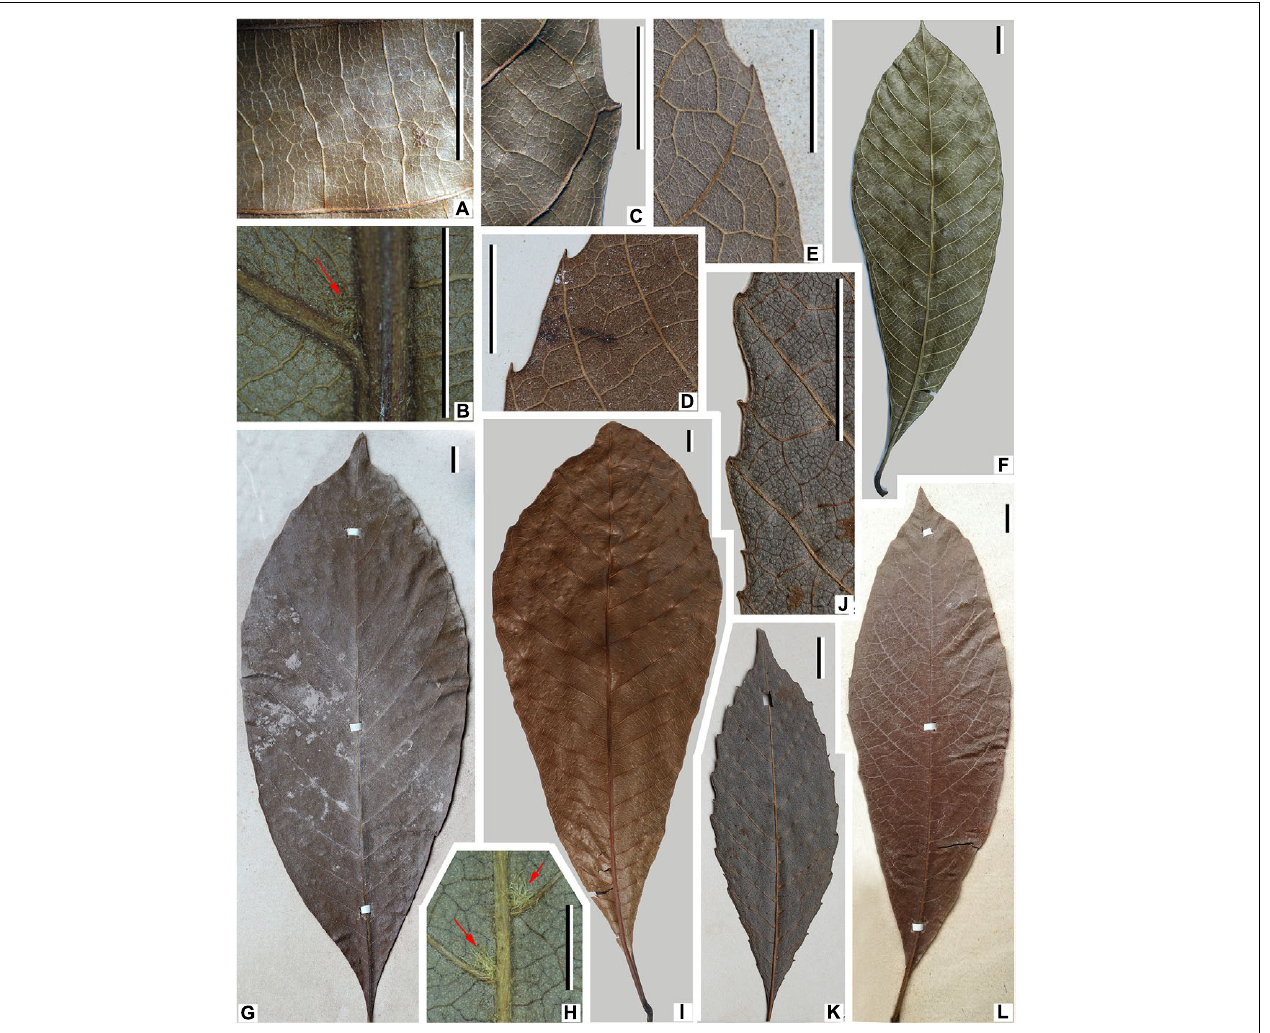
FIGURE 10 | Leaf morphology of extant Meliosma species. M. simplicifolia (Roxb.) Walp., XTBG (A–C,F,I) . (A) Tertiary and higher-order venation. (B) Leaf domatium (arrow) in the axil of midvein and secondary vein. (C) Marginal tooth. (F) Leaf with entire margin. (I) Leaf with an irregularly serrate margin. M. fordii Hemsl. (D,L) . (D) Marginal tooth, SYS00085158. (L) Leaf with irregularly serrate margin, SYS00085144. M. rigida Siebold et Zucc., SYS00085219 (E,G) . (E) Marginal tooth. (G) Leaf with an irregularly serrate margin. M. tenuis Maxim., SYS00085289 (H,J,K) . (H) Tuft of long trichomes (domatia) in axils of midvein and secondary veins. (J) Marginal teeth of two orders. (K) Leaf with biserrate margin. Scale bars = 1